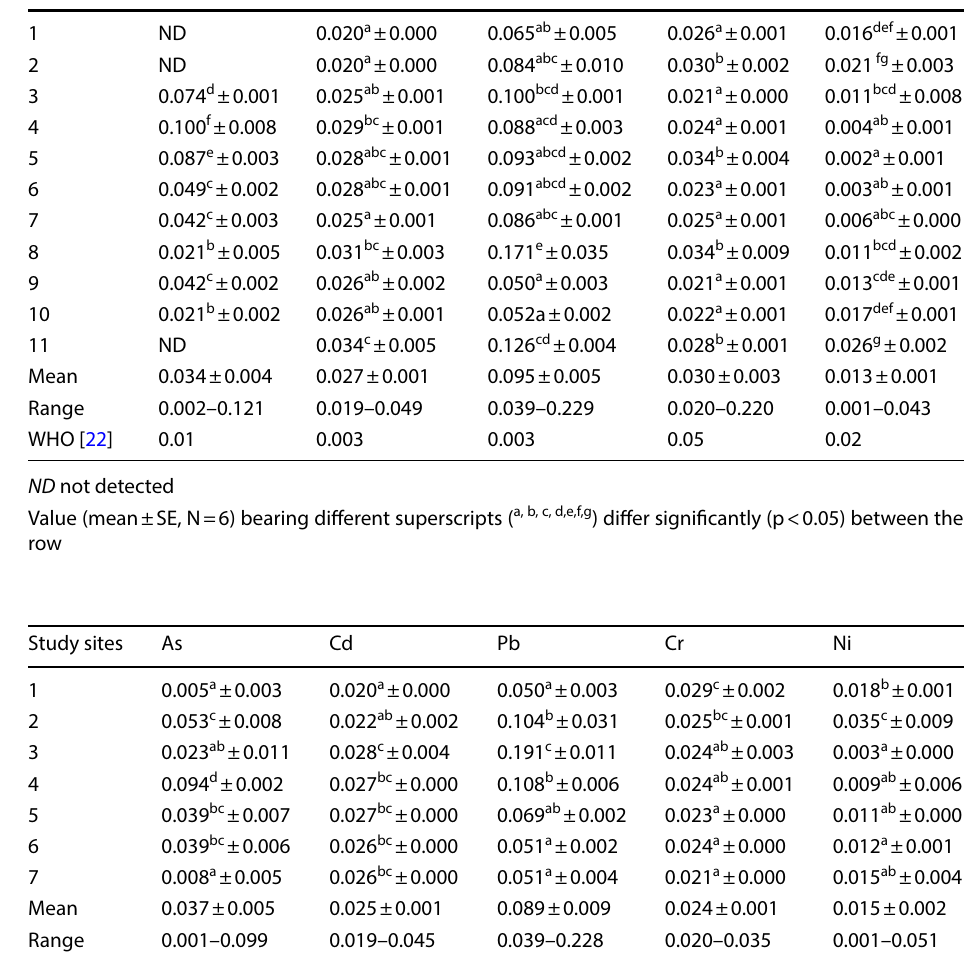
Table 5 Heavy metals concentration (ppm) in stagnant water (pond) of cold desert high-altitude trans- Himalayan region